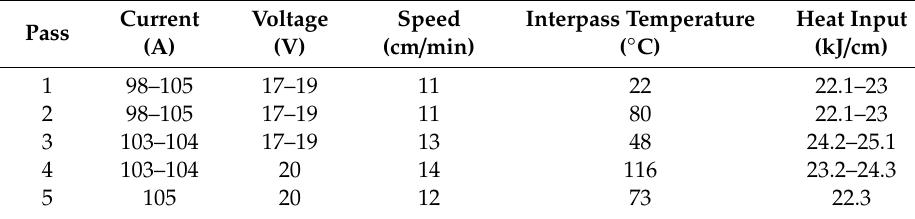
Figure1. Schematicdiagram ofdissimilarweld buttjointsusing A106Gr.B andA312TP316L basemetals. Figure 1. Schematic diagram of dissimilar weld butt joints using A106Gr.B and A312 TP316L base Table 2. Buttering welding conditions of ERNiCr-3 filler metals.